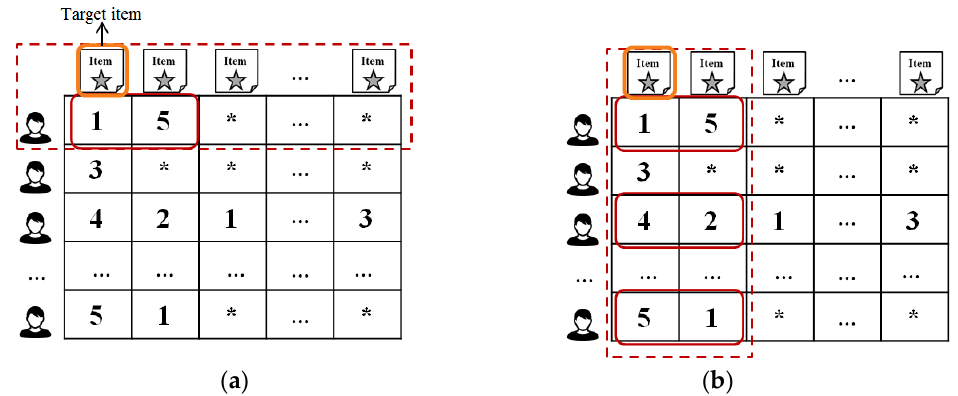
Figure 3. Example of time factor used in different step of IBCF. ( a ) Most related approaches apply the time factor into rating prediction step; ( b ) the proposed approach applies the time factor into similarity computation step.